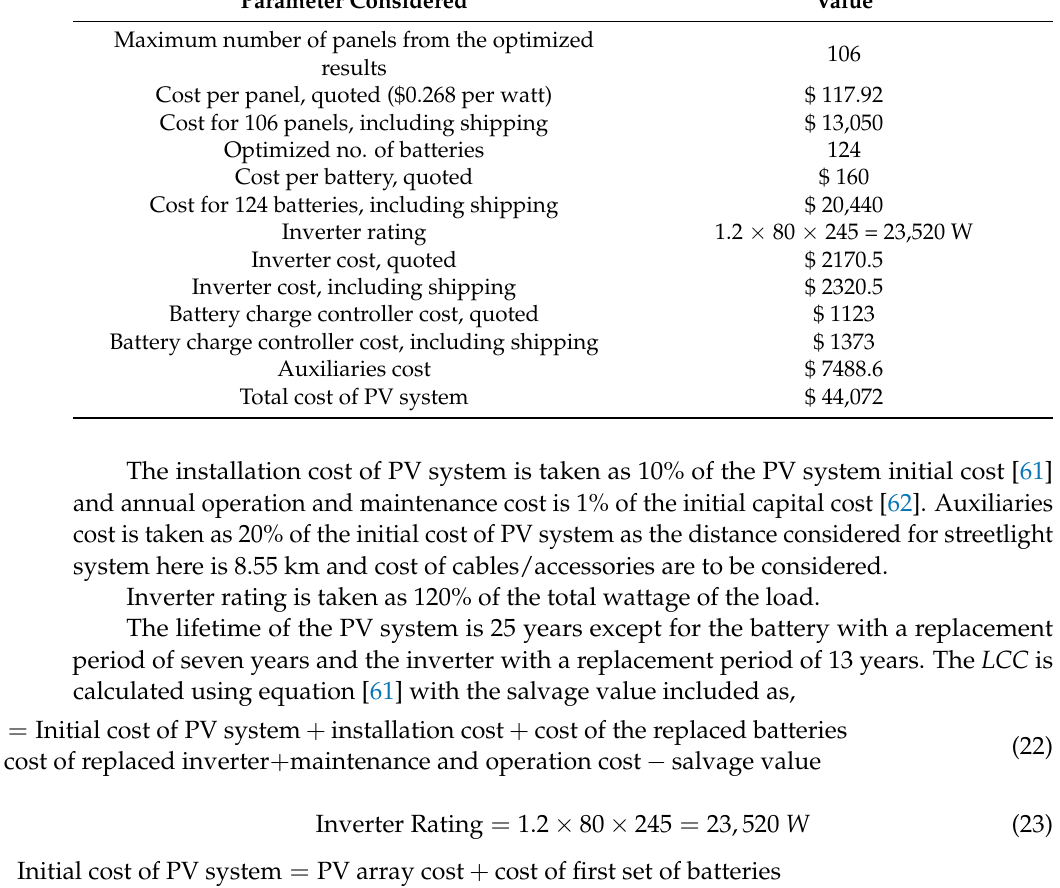
Table 11. Data required for evaluation of Life Cycle Cost. Parameter Considered